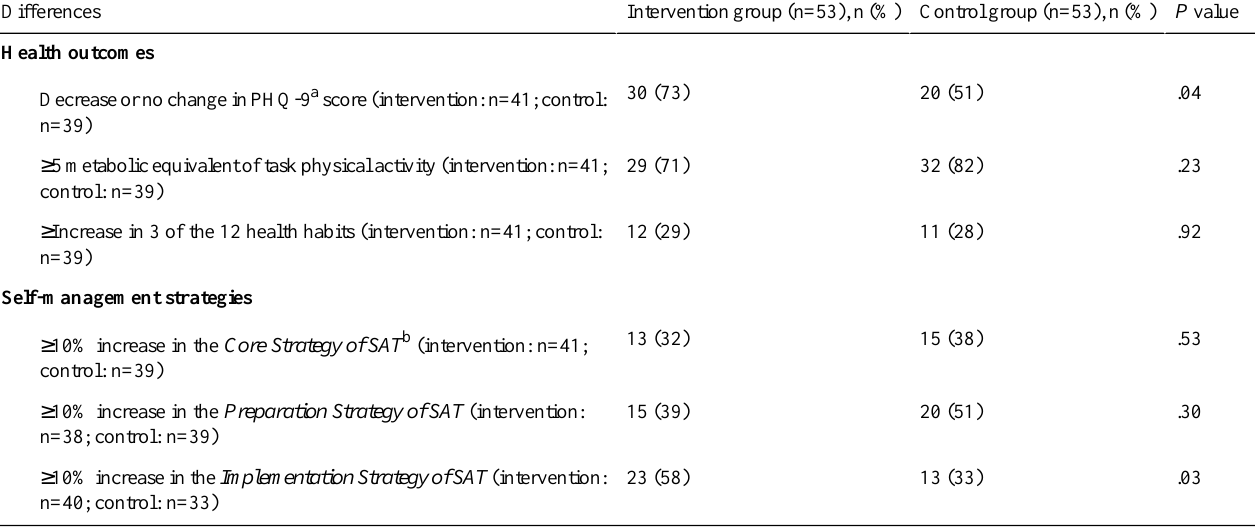
Table 4. Differences in health outcomes and self-management